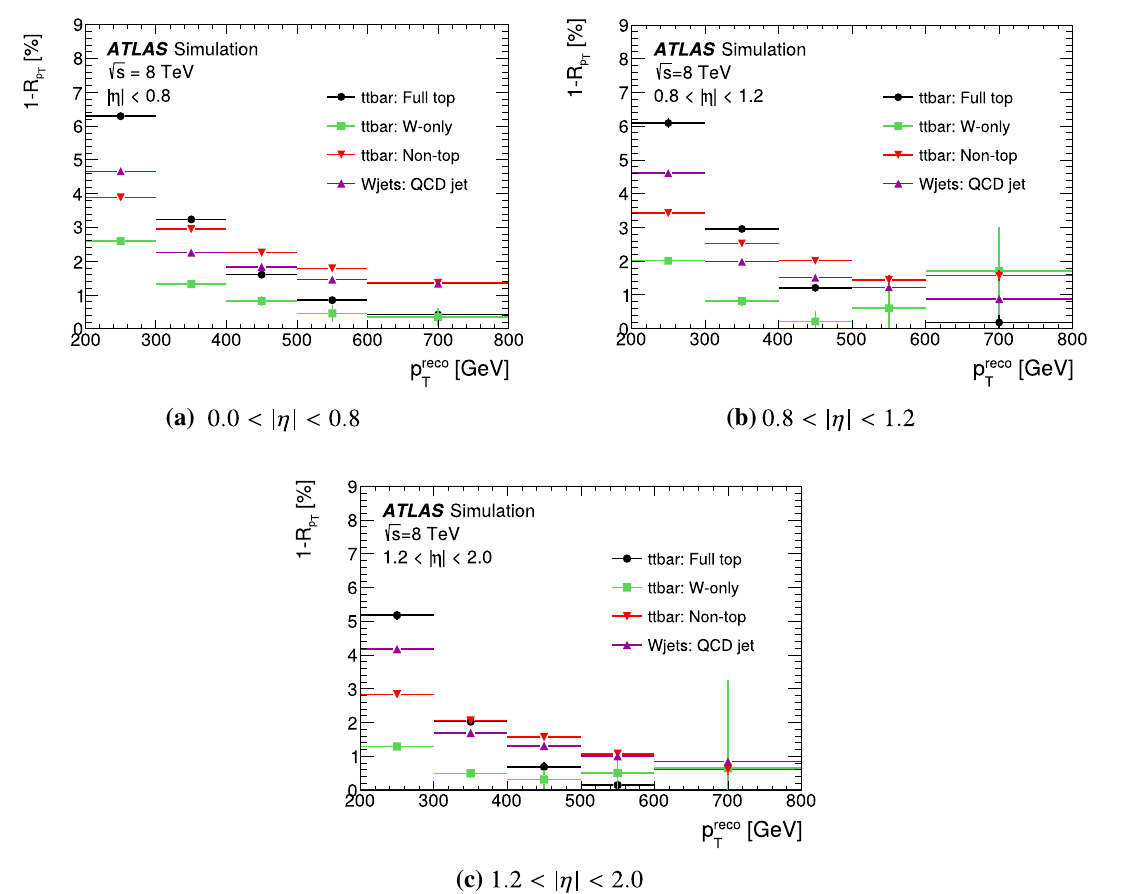
(cid:8) R = 0 . 8 of the jet axis while the b -quark fulfils (cid:8) R > 1 . 2; (3) “ t ¯ t − p reco (cid:9) / p truth = T T T non-top”jets(lowertriangles)thatrepresentjetsforwhichthetopquark is (cid:8) R > 2 . 0 from the jet; and, (4) “Wjets QCD” jets (upper triangles) representing jets from a leptonically decaying W boson in a W +jets MC sample. These are plotted as a function of reconstructed jet p T ( p reco ) , but due to the large bin size compared with the p T resolution, T the choice of plotting p reco or p truth is of little T T